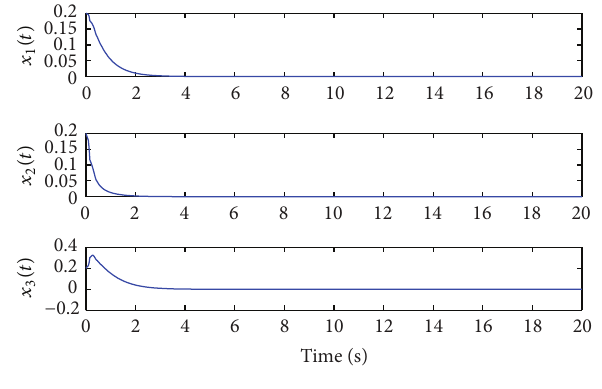
Figure 2: Time responses of states of the controlled nonlinear system without disturbances.